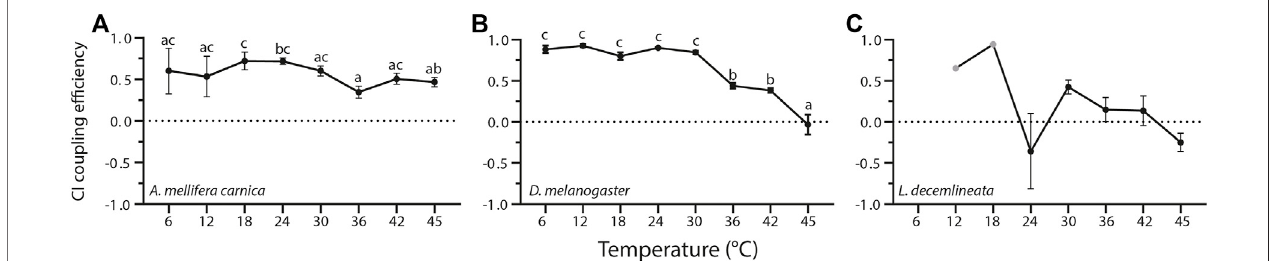
FIGURE 2 | Complex I coupling ef fi ciency calculated from mitochondrial oxygen consumption rates measured in permeabilized thoraces of the three insect species. (A) A. mellifera carnica ( n = 3 – 10), (B) D. melanogaster ( n = 3 – 10), and (C) L. decemlineata ( n = 0 – 10). Complex I coupling ef fi ciency was calculated as 1-(CI- LEAK/CI-OXPHOS), and reported as mean ± s.e.m. Complex I coupling ef fi ciency values were compared within species between assay temperatures using a one-way ANOVA followed by a HSD (Honest Signi fi cant Difference) Tukey ’ s test. Dissimilar letters indicate signi fi cant differences within species. In L.decemlineata , CI coupling ef fi ciency values were not calculated for 6 ° C, and only one value was used for 12 and 18 ° C (grey